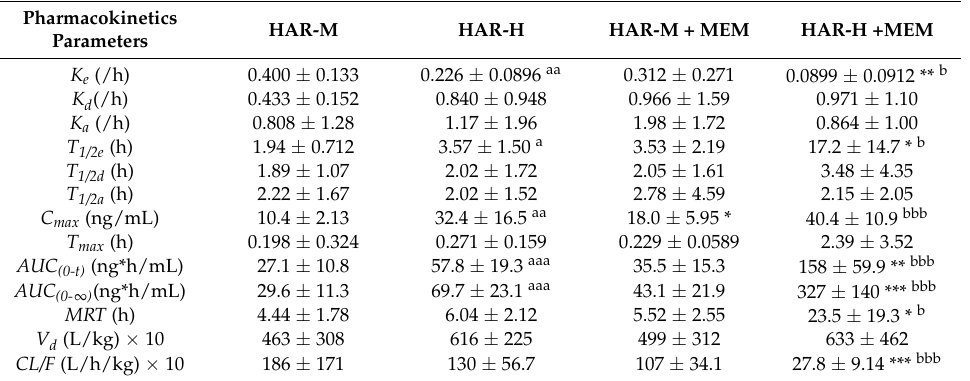
Table 3. Pharmacokinetics parameters of HOL in rats plasma after oral administration of medium (40.0 mg/kg) and high (80.0 mg/kg) doses of HAR and medium (40.0 mg/kg) and high (80.0 mg/kg) doses of HAR combined with MEM (5.0 mg/kg) (n = 8, mean ±